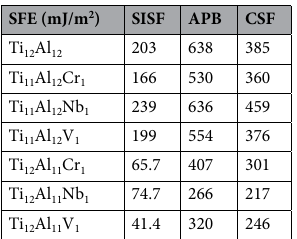
Table 2. Calculated stacking fault energies of each alloy. Results for supercells with 24 atoms are presented. Corresponding atomic configurations are presented in Fig. 3.